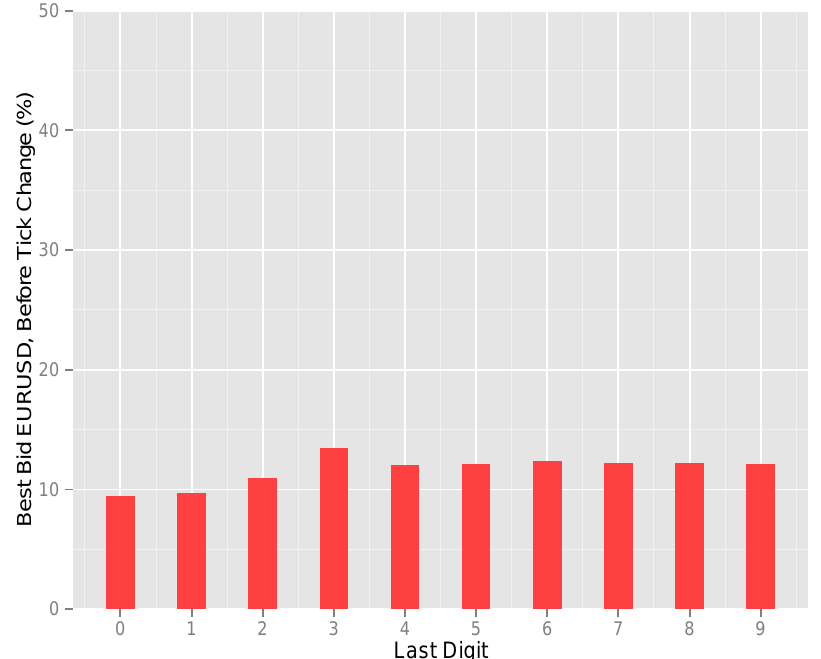
Figure 15. Best Bid Last Digits, Before Tick Change.